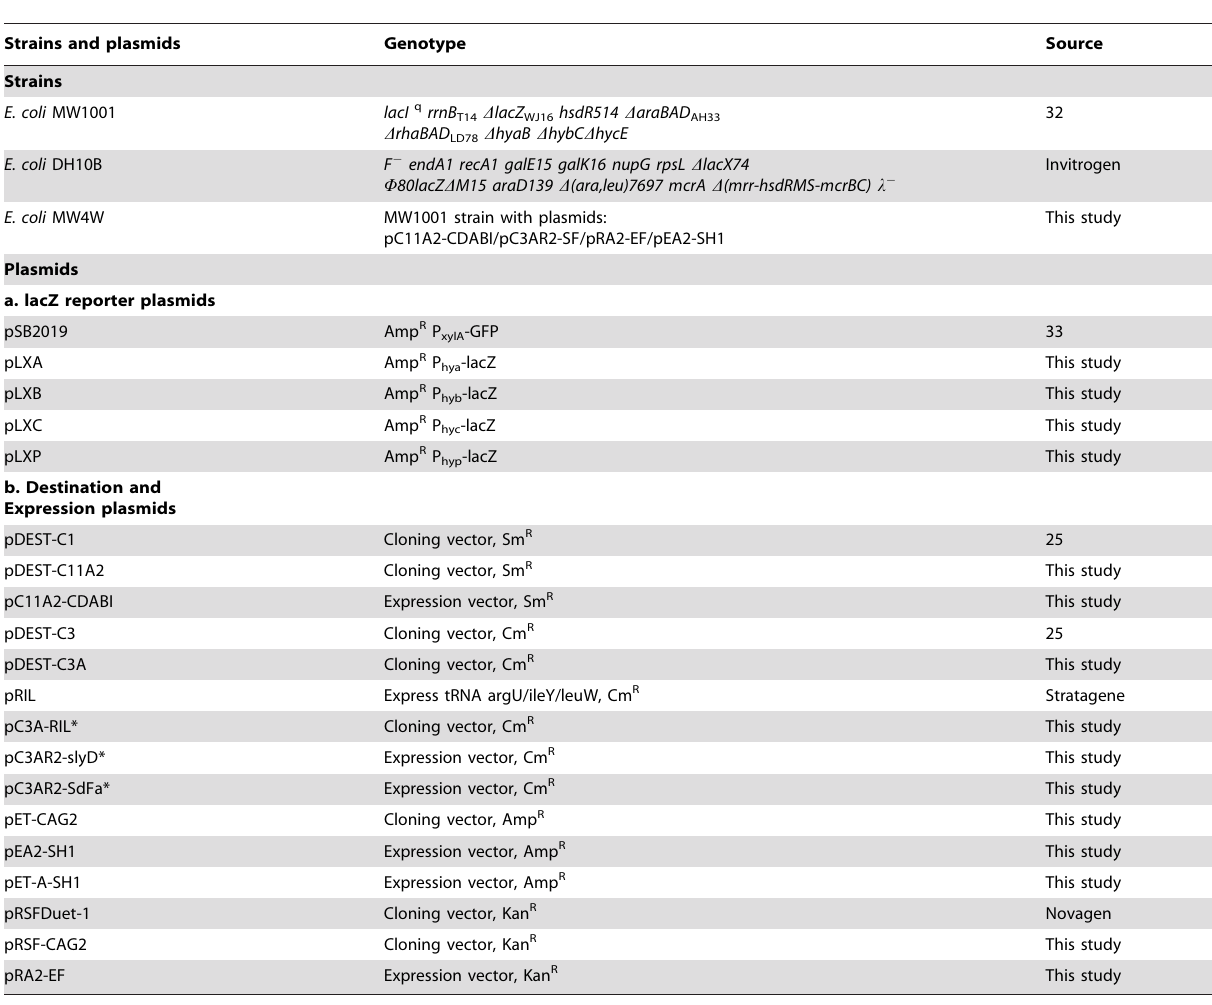
Table 1. Strains and plasmids used in this